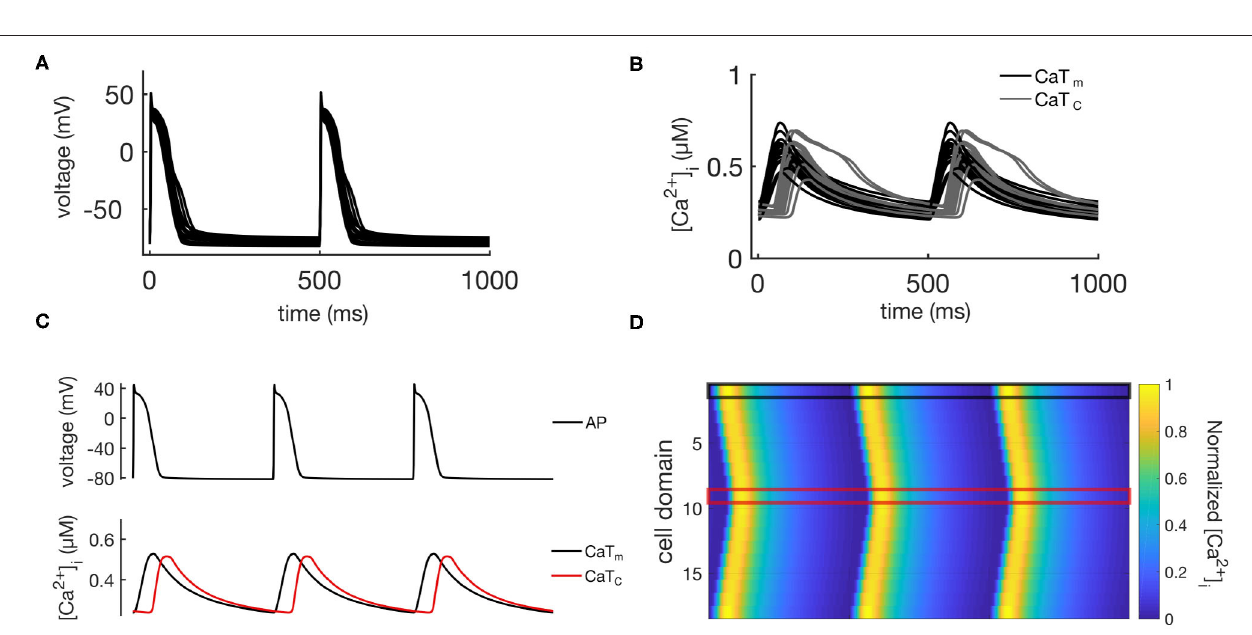
FIGURE 1 | Schematic representation of the rabbit cardiomyocyte model, showing how a transversal cell segment is divided into individual domains. Calcium enters the cell via L-type channels in the membrane domains (1 and 18) and diffuses toward the cell center. Each domain has its own sarcoplasmic reticulum and calcium release units, while the membrane domains also include membrane currents and sub-sarcolemmal spaces.